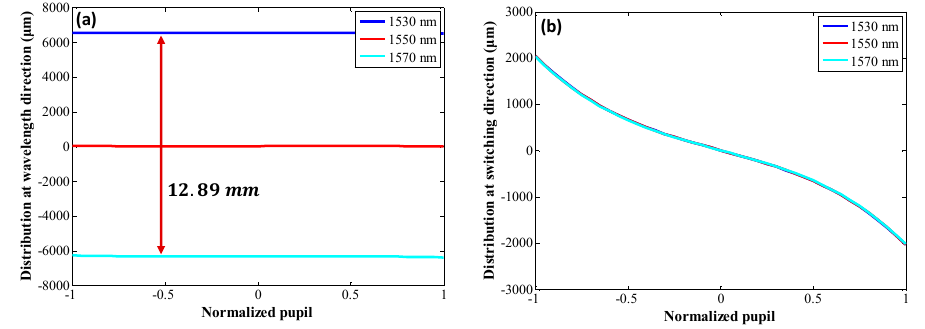
Figure 3. Simulation results using Zemax, ( a ) at the wavelength direction and ( b ) at the switching direction.